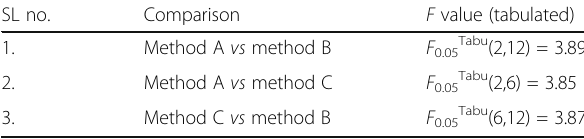
Table 6 Results of two ways analysis of variance (ANOVA) SL